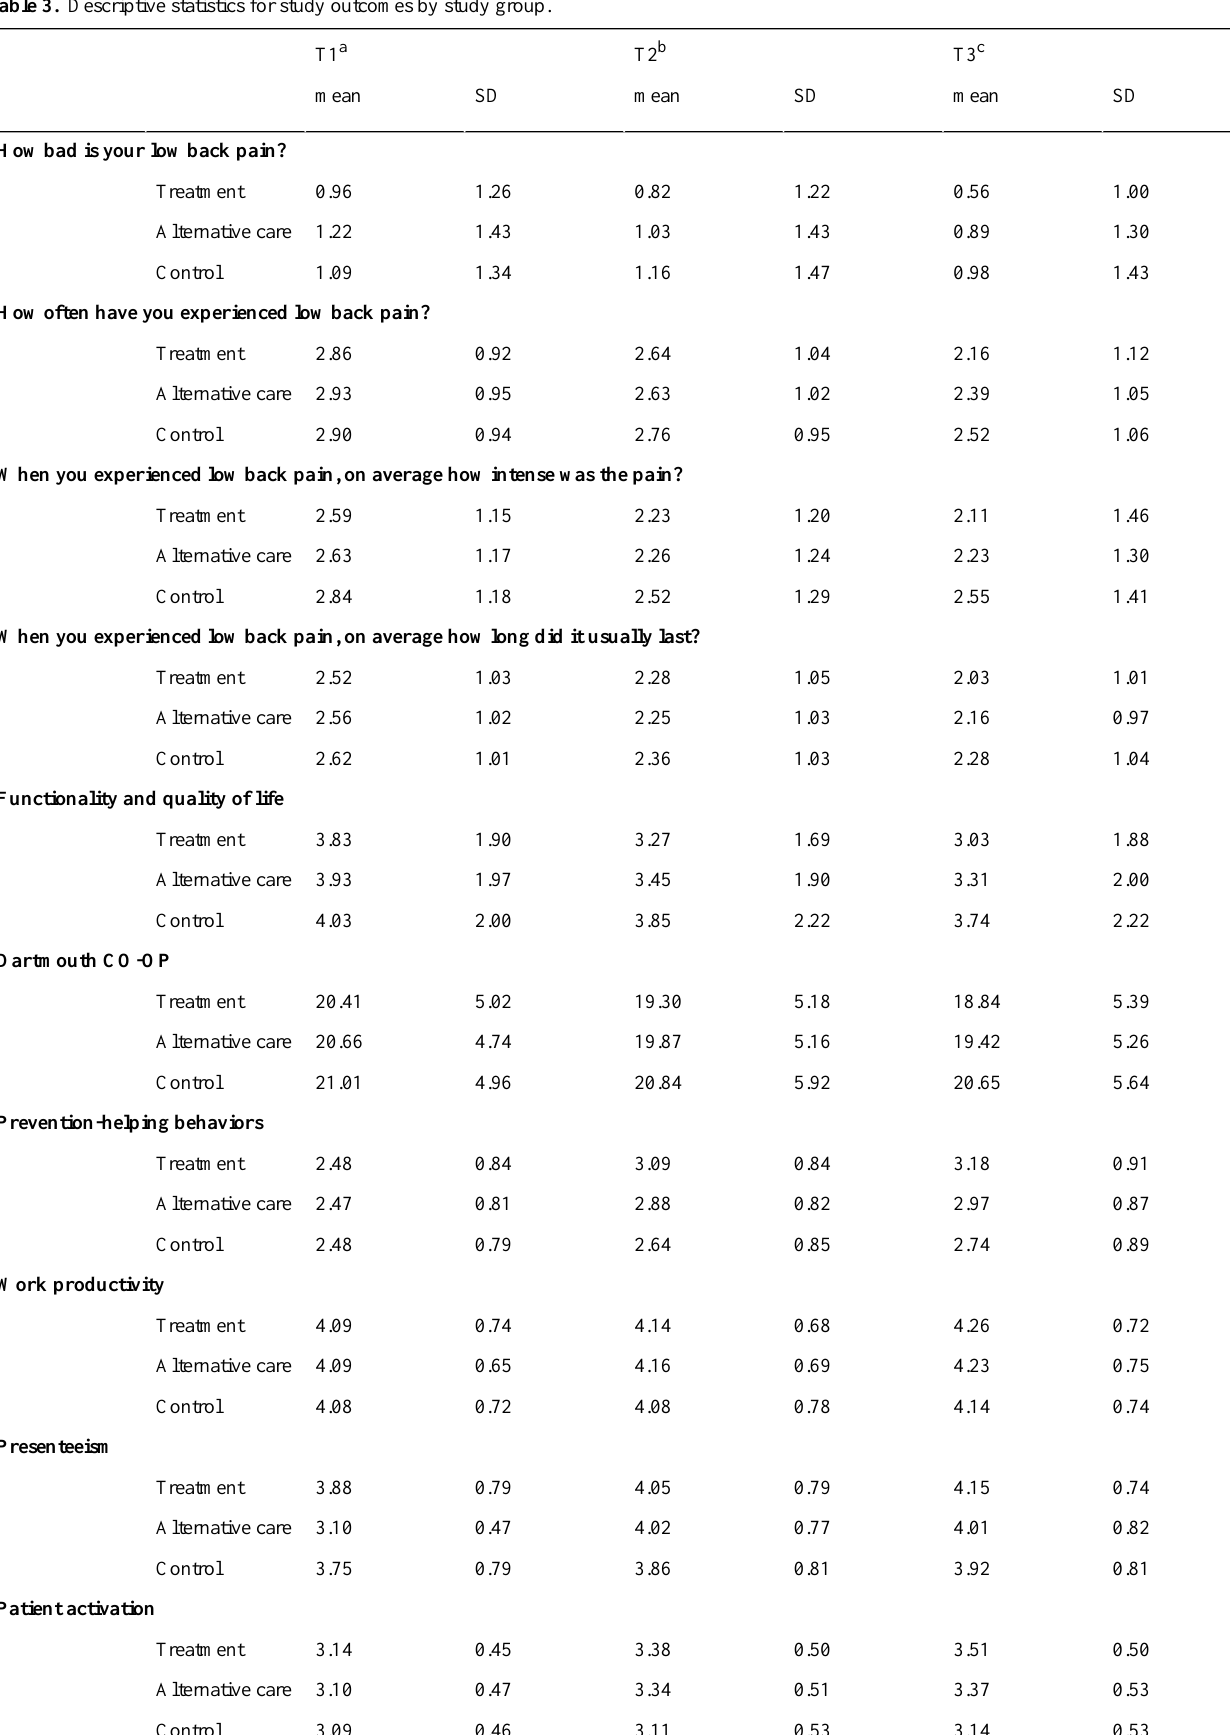
Table 3. Descriptive statistics for study outcomes by study